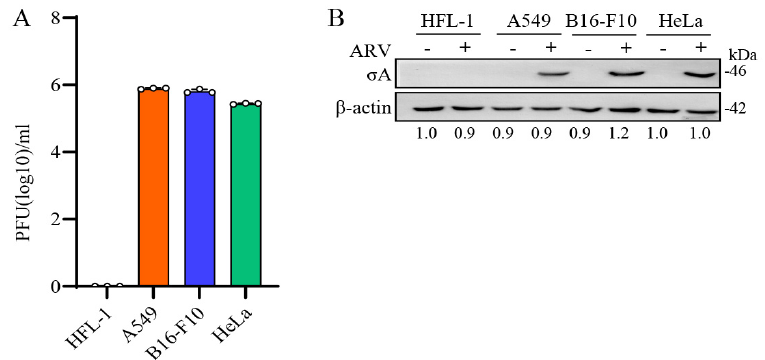
Figure 1. ARV replication in several cancer cell lines. ( A ) HFL-1, A549, B16-F10, and HeLa cell lines were infected with ARV at an MOI of 10 for 24 h. Plaque assay was performed to analyze the titer of ARV. HFL-1 cell as the negative control for this experiment. All data were obtained in three independent experiments, error bars indicate the mean ± SD. ( B ) Four cell lines were treated in the same way and examined using Western blots. Signals in all Western blots of β -actin were quantified with Image